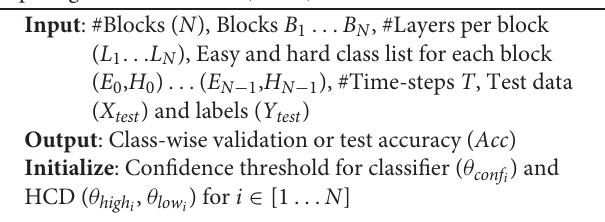
Algorithm 3: Fast inference, with early exit, algorithm for spiking neural networks